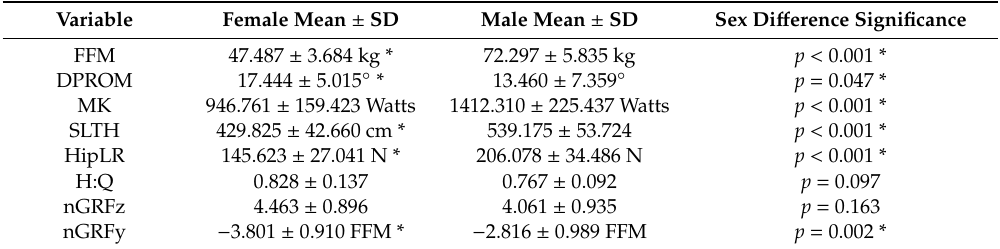
Table 2. Means and standard deviations for independent and dependent